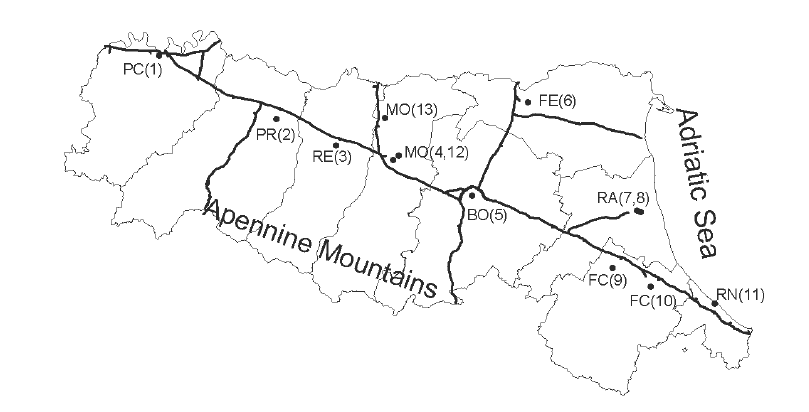
Figure 1 – The monitoring sites’ spatial location. The bold lines indicate the main roads, while the dots indicate the monitoring sites locations: the letters are abbreviations for the names of the towns, while the monitoring site identifying numbers are shown in